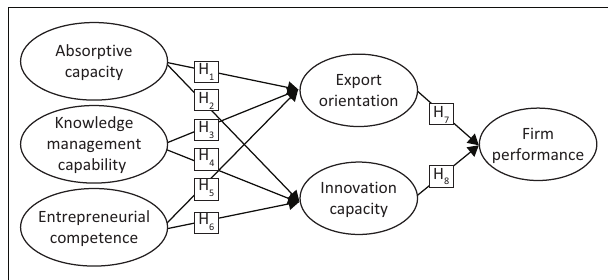
FIGURE 1: Conceptual